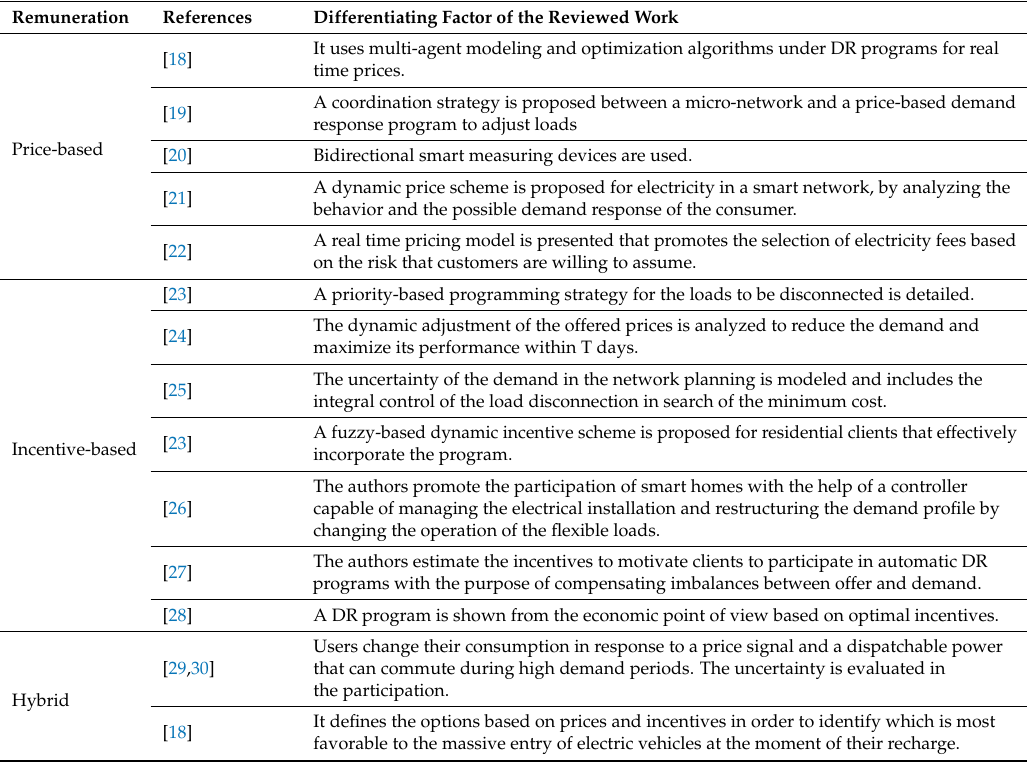
Table 1. DR programs in terms of the remuneration